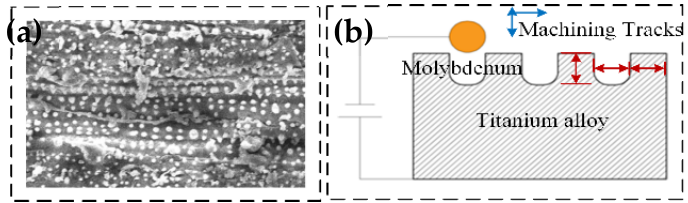
Figure 1. Macrostructure processing schematic diagram. ( a ) Rice leaf and SEM image of macro-micro complex structure on the leaf surface. Reproduced with permission from Ref. [37] ( b ) Machining tracks of macrostructure.